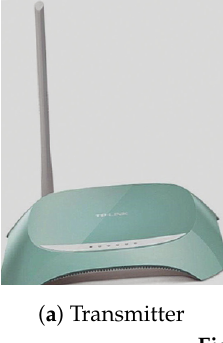
Figure 6. Experimentation equipment.